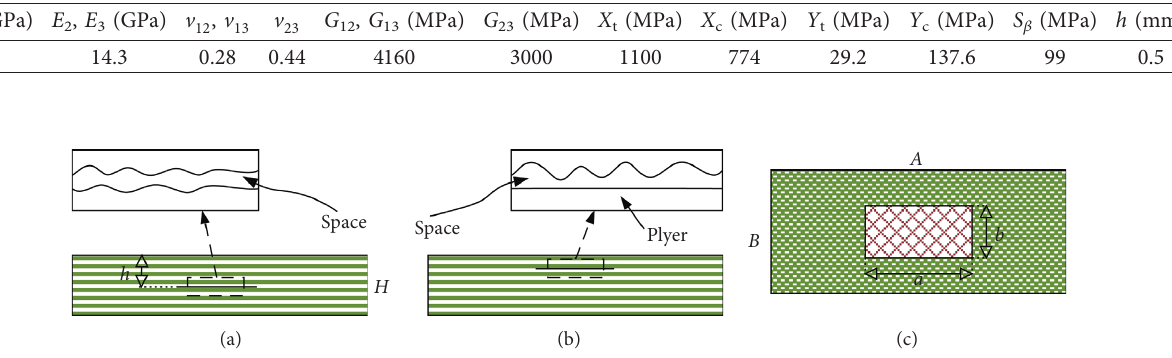
Figure 3: Different delaminations of UDL: (a) delamination close to the midsurface; (b) delamination close to the surface; (c) plan view of